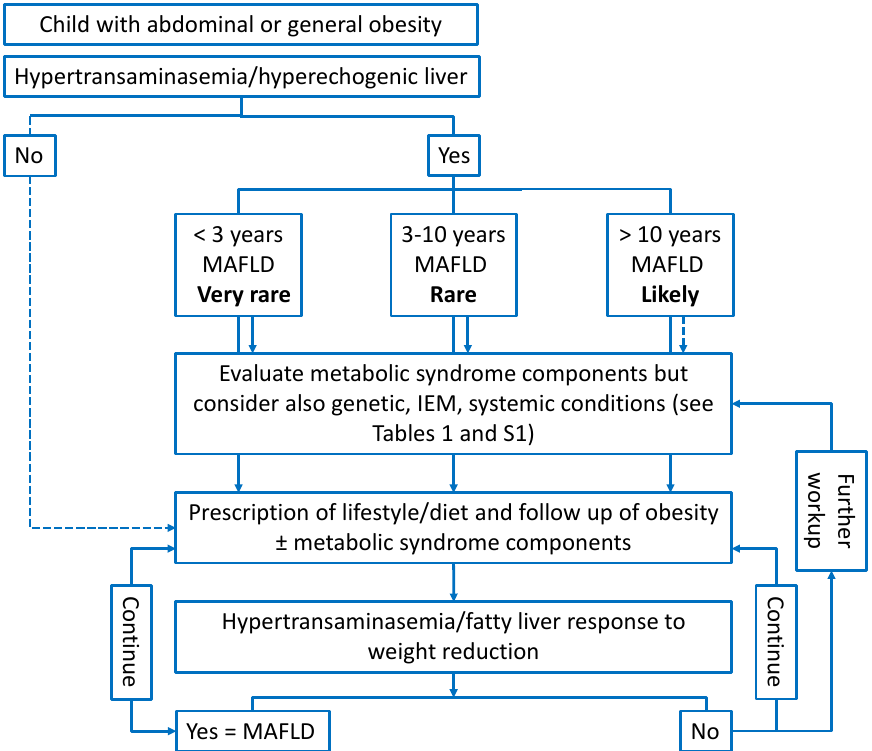
Figure 2. Suggested algorithm for the assessment of liver disease in a child with abdominal/general obesity and hypertransaminasemia/hyperechogenic liver according to age range and to response to weight reduction. Notes: Further work-up for genetic-IEM causes, according to Hegarty et al [2]. Blood: 1) glucose, ketones, lactate, uric acid, creatine kinase, ammonia, thyroid function test, lipid profile, hepatitis serology and molecular testing; 2) acylcarnitine and amino acids profile, carnitine (free and total); 3) alpha 1-antitrypsin phenotype; 4) glucose tolerance test; 5) copper studies; 6) sweat test; 7)